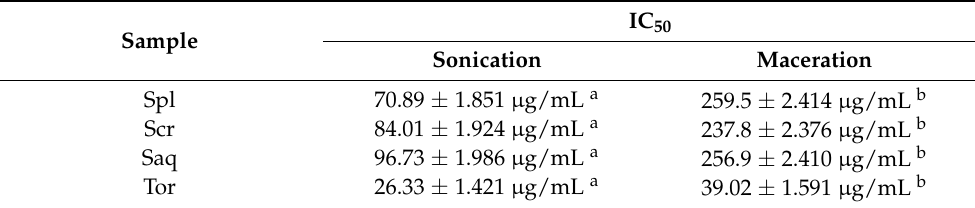
Table 2. IC 50 values of brown algae cold maceration and UAE (sonication) extract towards the B16-F10 melanoma cell line observed with MTT